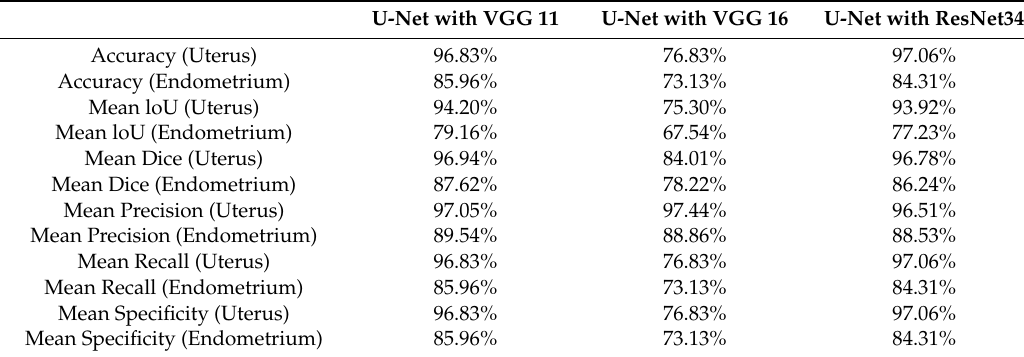
Table A1. Verification summary of the performance of three AI models on contrast-enhanced T1w using the validation dataset. The parameters of accuracy, sensitivity and specificity for both uterus and endometrium are shown.